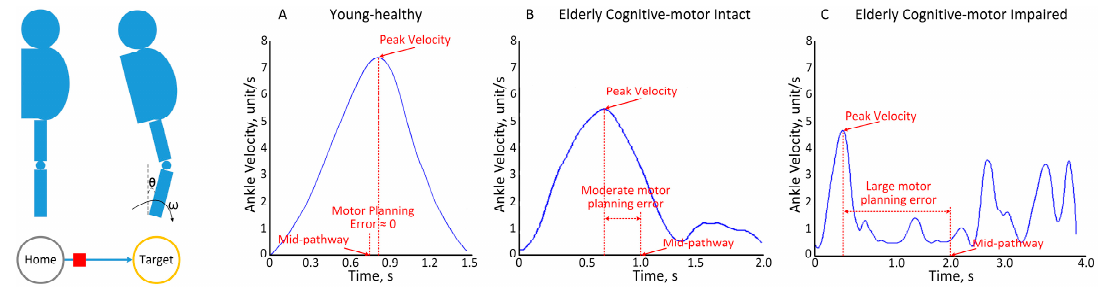
Figure 2. An illustration of the iTMT MPE. ( A ) Ankle velocity curve of a typical young-healthy subject during the ankle reaching, ( B ) ankle velocity curve of a typical elderly cognitive–motor intact subject during the ankle reaching, ( C ) ankle velocity curve of a typical elderly cognitive–motor impaired subject during the ankle reaching.